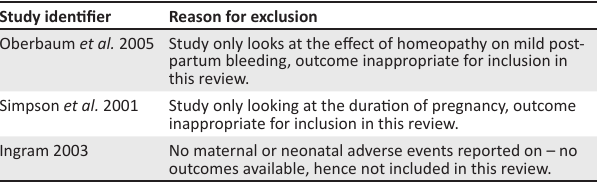
TABLE 2: Excluded